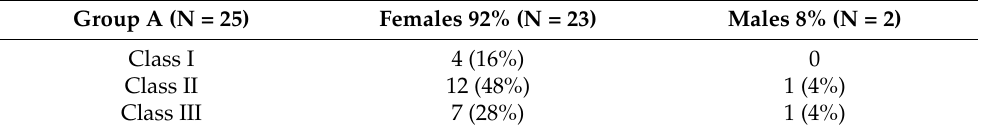
Table 1. Absolute frequency and percentage (n (%) values) of Group A in the different skeletal Classes. Group A (N = 25)